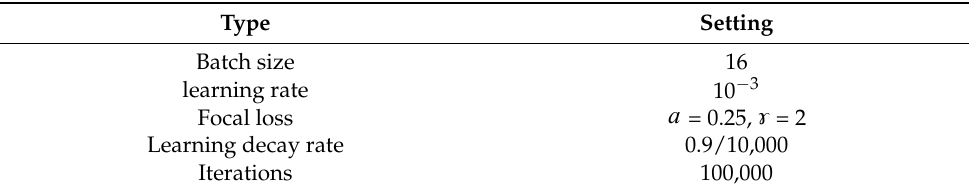
Table 3. Training parameter settings.